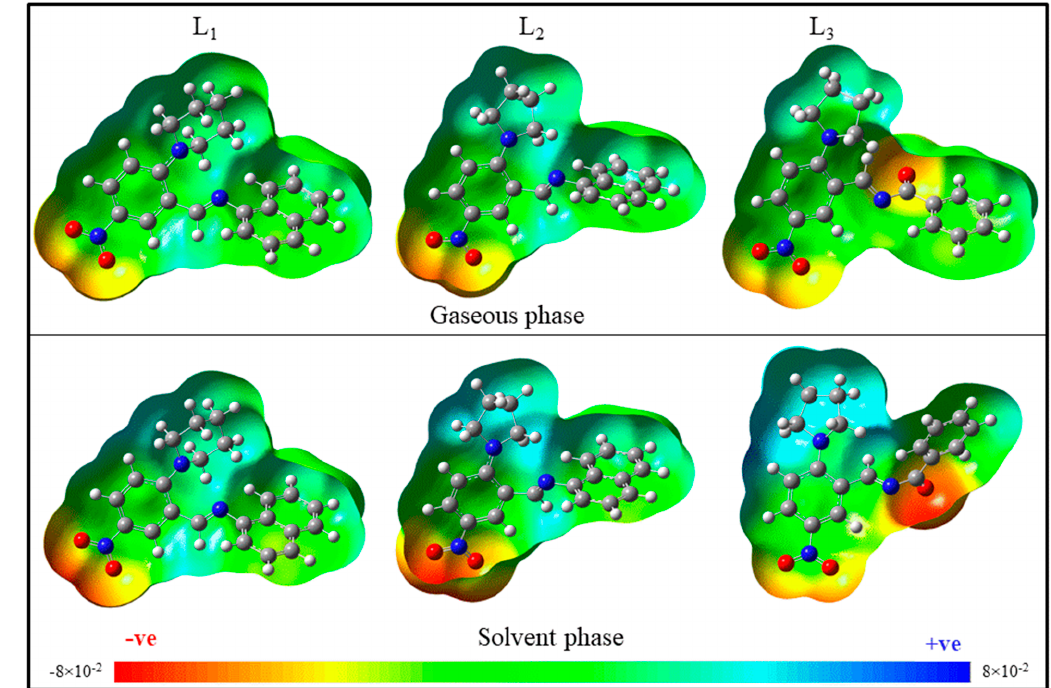
Figure 6. Molecular electrostatic potential map of L 1–3